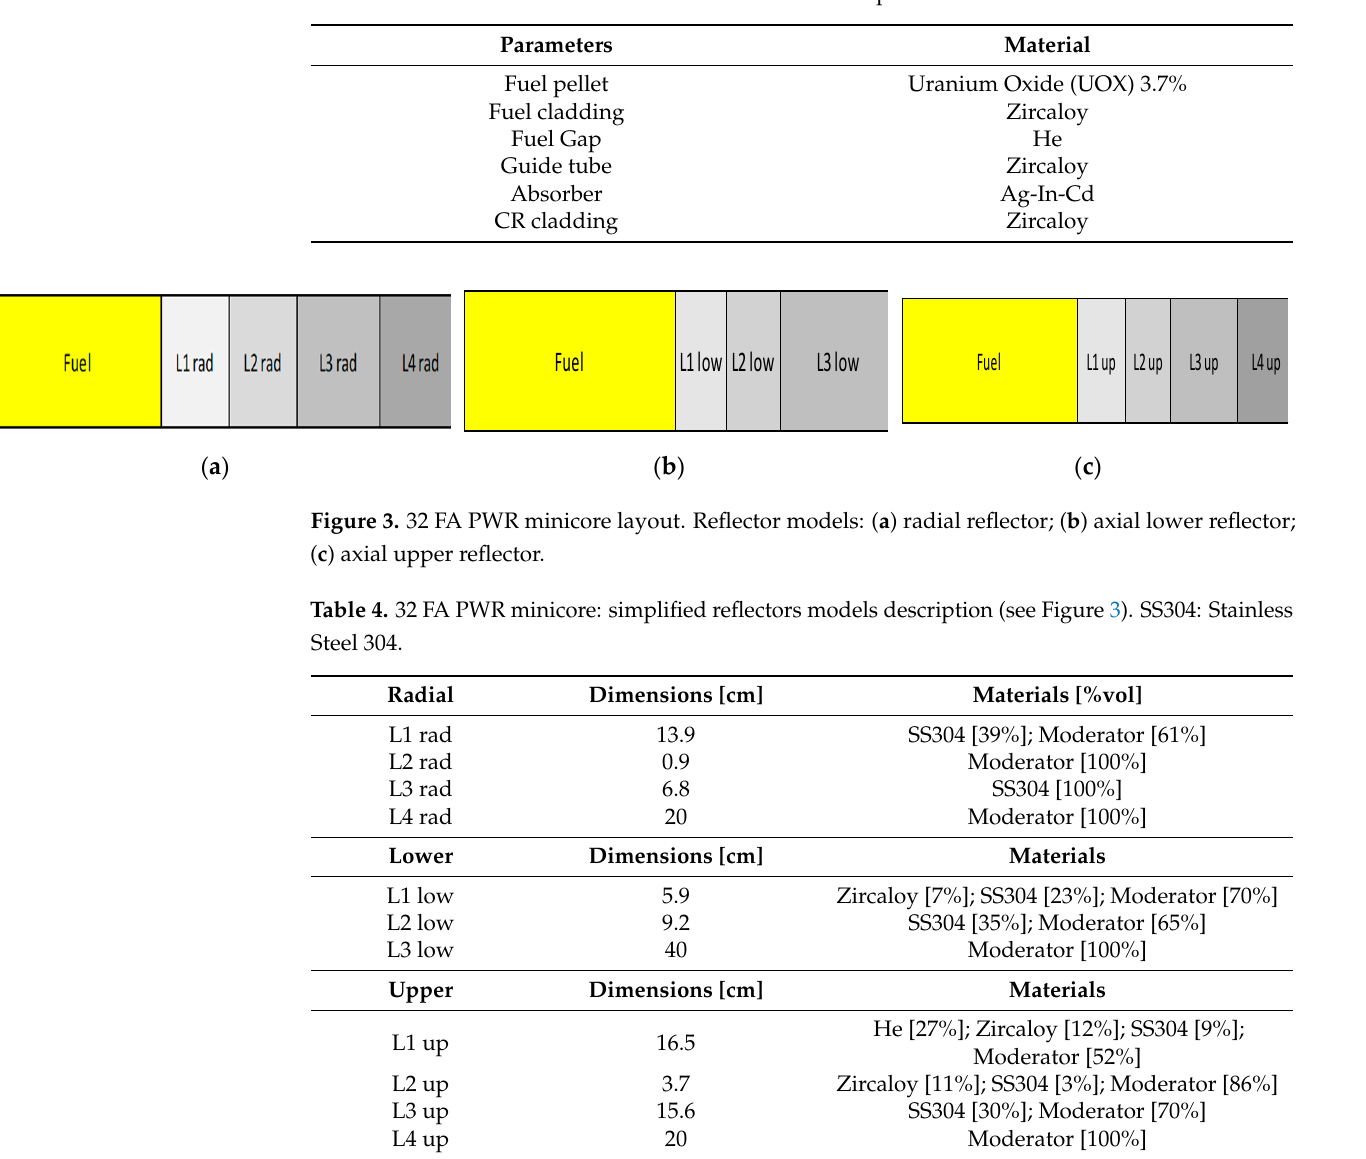
Figure 2. 32 FA PWR minicore layout. Simplified scheme: ( a ) radial configuration; ( b ) axial Table 3. 32 FA PWR minicore: FAs and CRs material composition. configuration.